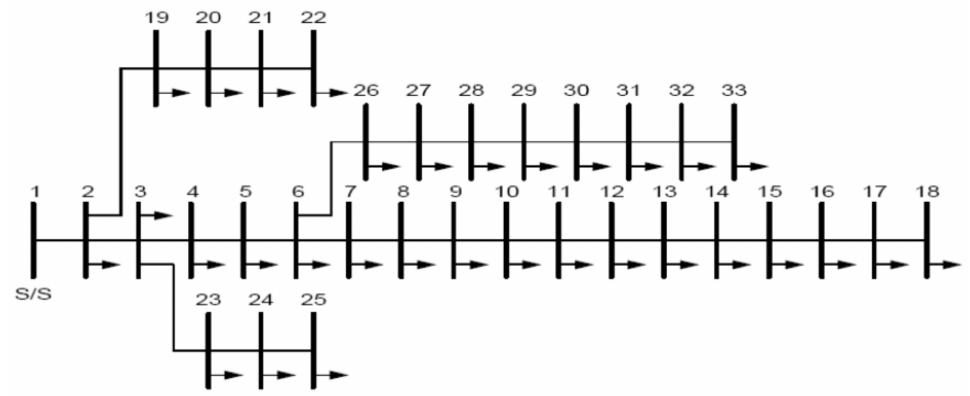
Figure 2. A case study of the 33-bus system under study